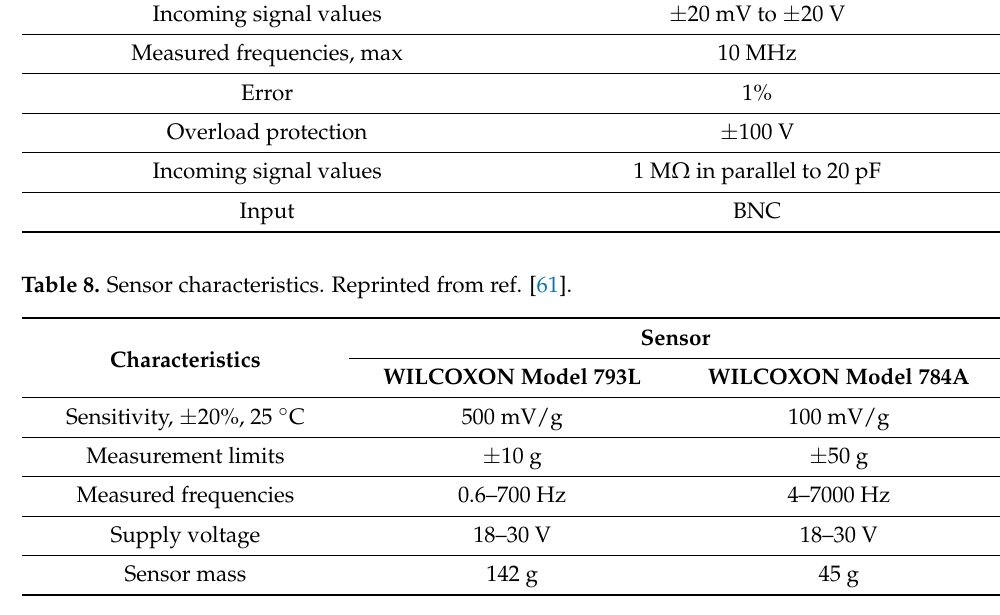
Table 7. Characteristics of the PicoScope 3424 signal converter. Reprinted from ref. [60].